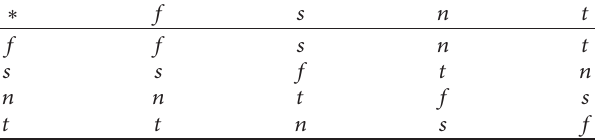
Table 2: Table representation of hybrid structure 􏽥 g Z 􏽥 g 􏽥 δ